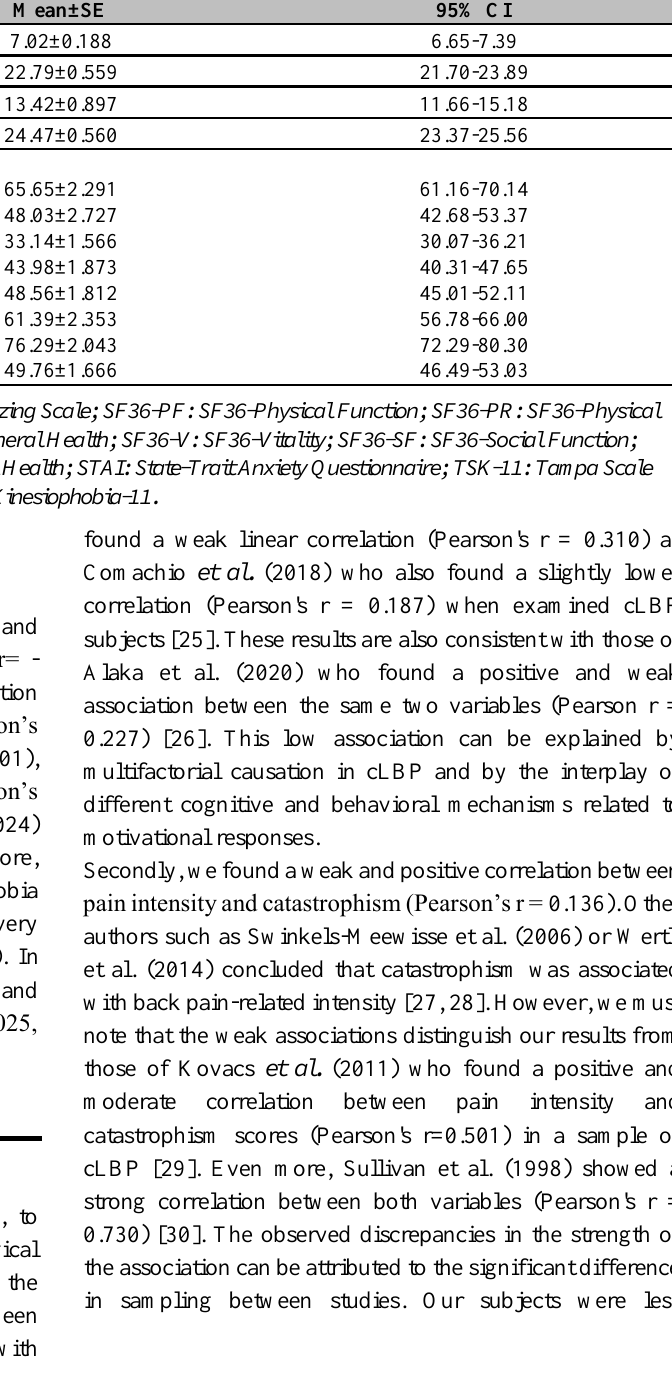
Table 2: Descriptive analysis of variables analyzed